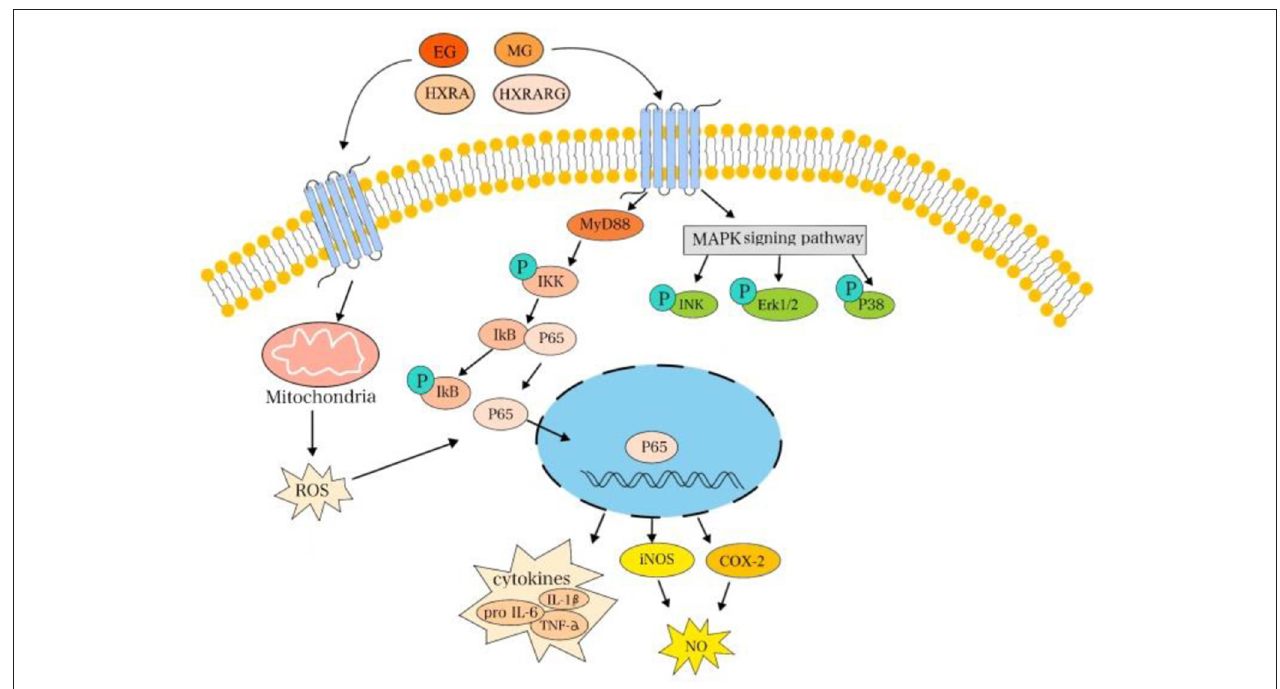
FIGURE 10 | EG, MG, HXRARG, and HXRA activate NF- κ B and MAPK signaling pathways to promote the activation of RAW264.7